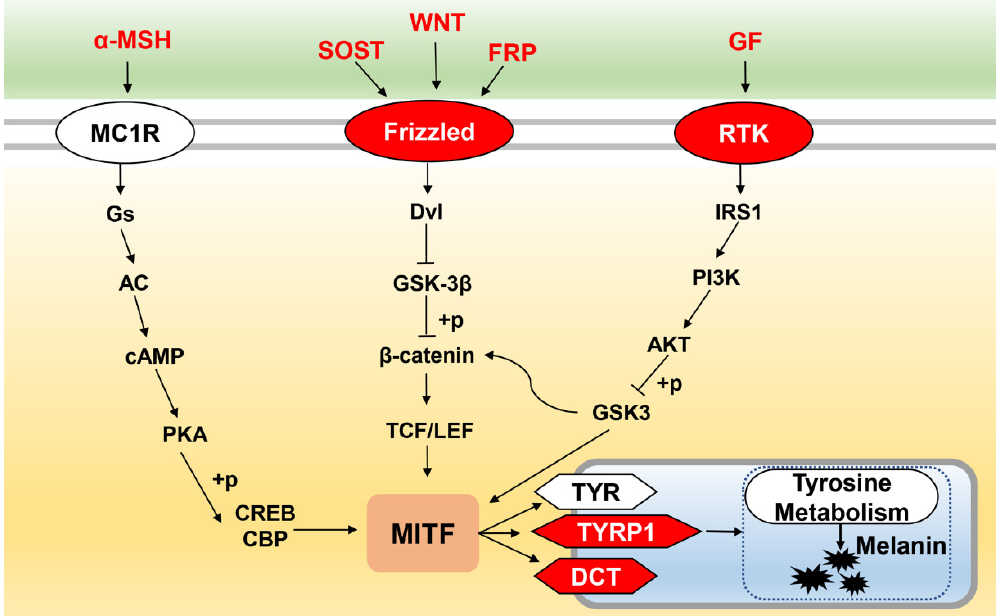
Figure 8. The hypothesis regarding the regulation mechanism of the effect of background color on skin color variation in P. leopard . Red words and white words on the red background means upregulated genes.